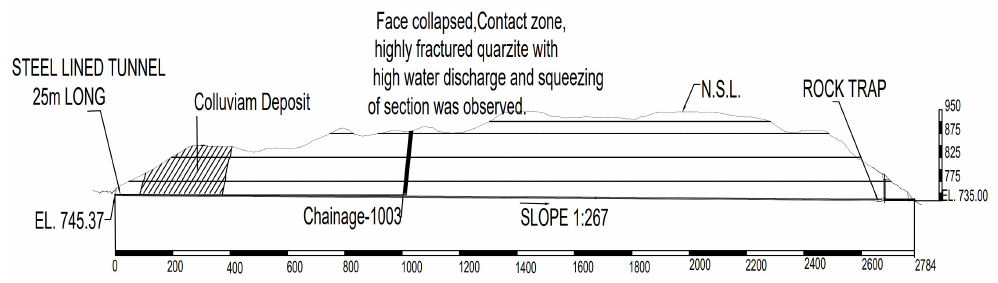
Figure 4. A typical section of the head race tunnel of DKHP.